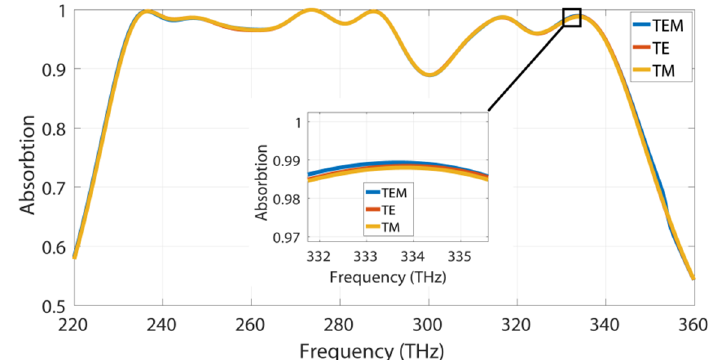
Figure 4. Absorption characteristics under the transverse electromagnetic mode (TEM)-, TE- and TM-polarized wave.